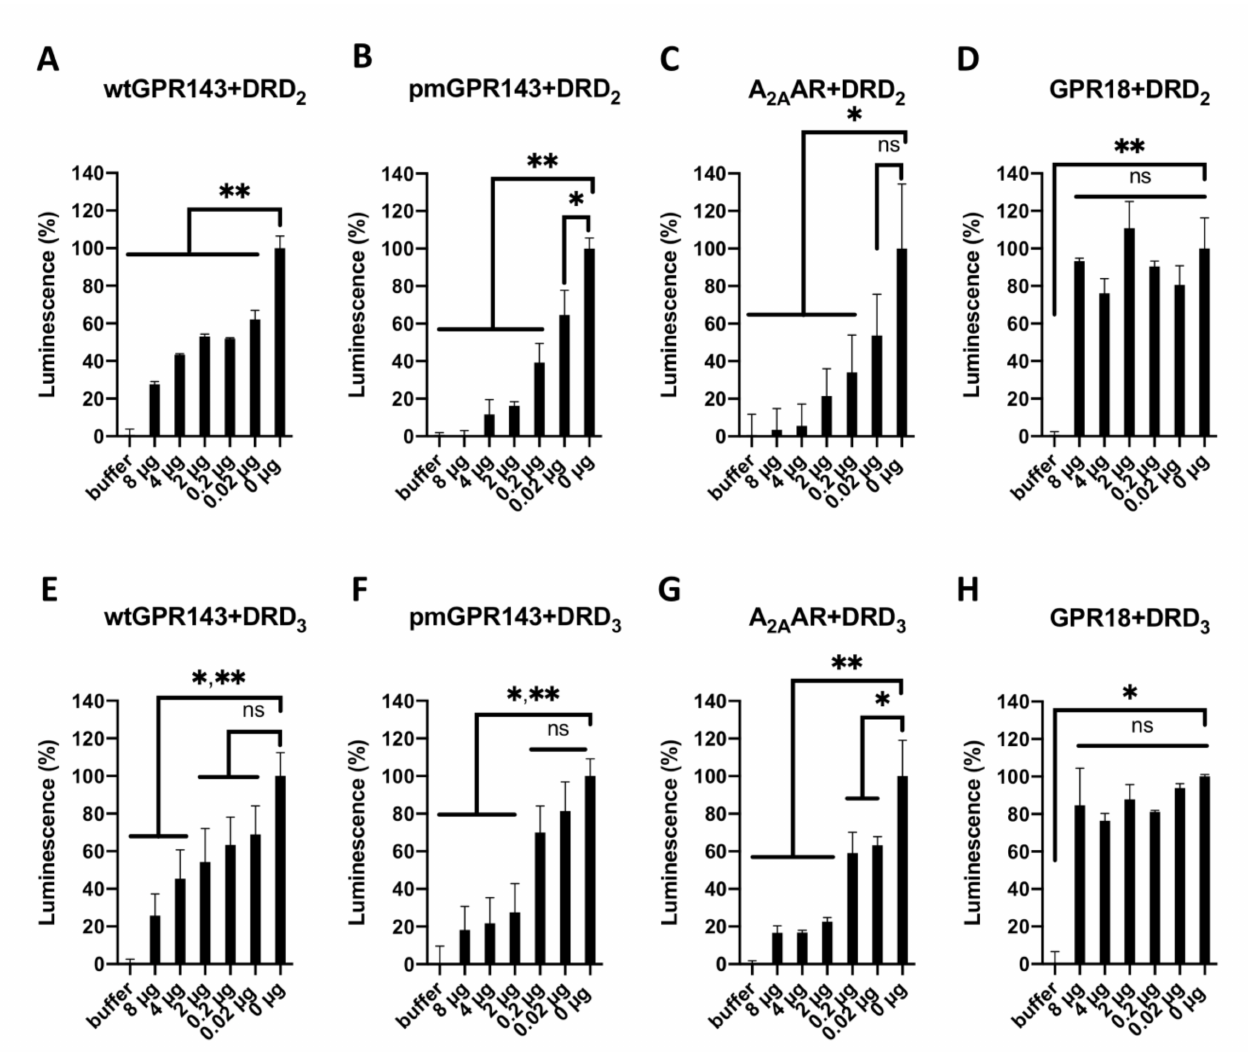
Figure 5. Dopamine response of CHO β -Arrestin DRD 2 and DRD 3 cells co-transfected with different concentrations of wtGPR143-, pmGPR143-, A 2A AR- and GPR18-YFP in the β -Arrestin recruitment assay. CHO β -Arrestin DRD 2 and DRD 3 cells were transfected with different amounts of plasmids containing receptor cDNA (8, 4, 2, 0.2, and 0.02 µ g) and treated with 10 µ M dopamine (or buffer). Data were normalized to buffer (0%), and DRs only (0 µ g, 100%) and correspond to mean ± SEM of two to three independent experiments performed in triplicates or quadruplicates. ( A ) Coexpression of wtGPR143 had a significant effect on DRD 2 at all concentrations ( p < 0.0001). ( B ) Coexpression of pmGPR143 had a significant effect overall on DRD 2 activity ( p < 0.0127). The 0 µ g vs. 0.02 µ g sample differed less ( p = 0.003), while the other concentrations differed more significantly ( p < 0.0001 for 0 µ g vs. 0.2–8 µ g). ( C ) Coexpression of A 2A AR did not have a signif- icant effect on DRD 2 for 0 µ g vs. 0.02 µ g ( p = 0.1037), while significant differences were observed for the other concentrations (0.2 µ g p = 0.0445; vs. 2 µ g p = 0.0222; vs. 4 µ g p = 0.0066; vs. 8 µ g p = 0.0066). ( D ) Coexpression of GPR18 had no significant effect on DRD 2 ( p > 0.05 for all). ( E ) Coexpression of wtGPR143 had a significant effect on DRD 3 at concentrations of 4 µ g and 8 µ g ( p = 0.0301, p = 0.0024). ( F ) Coexpression of pmGPR143 had a significant effect on DRD 3 overall ( p < 0.0001). Post-hoc comparisons indicated significant differences in activity for concentrations greater than 2 µ g (vs. 2 µ g p = 0.012; vs. 4 µ g p = 0.0006, vs. 8 µ g p = 0.0004). ( G ) Coexpression of A 2A AR had a significant effect on DRD 3 . Post-hoc comparisons indicated that the transfection of 0.02 µ g and 0.2 µ g significantly differed from the 0 µ g sample ( p = 0.071; p = 0.0066, respectively), while higher concentrations had a greater effect (vs. 2–8 µ g p < 0.0001 for all). ( H ) Coexpression of GPR18 had no significant effect on DRD 3 ( p > 0.05 for all, except for buffer). * = p ≤ 0.05; ** = p ≤ 0.01. ns = not